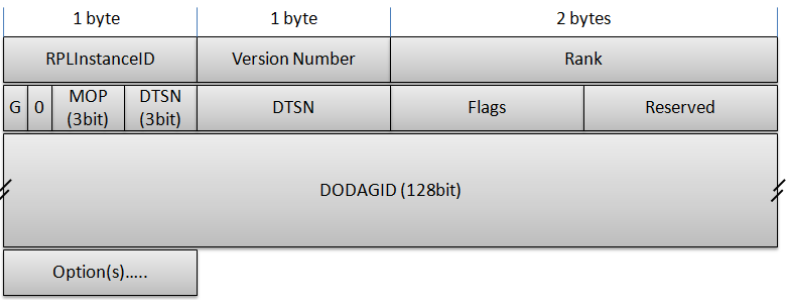
Figure 11. The DODAG Information Object (DIO) Base